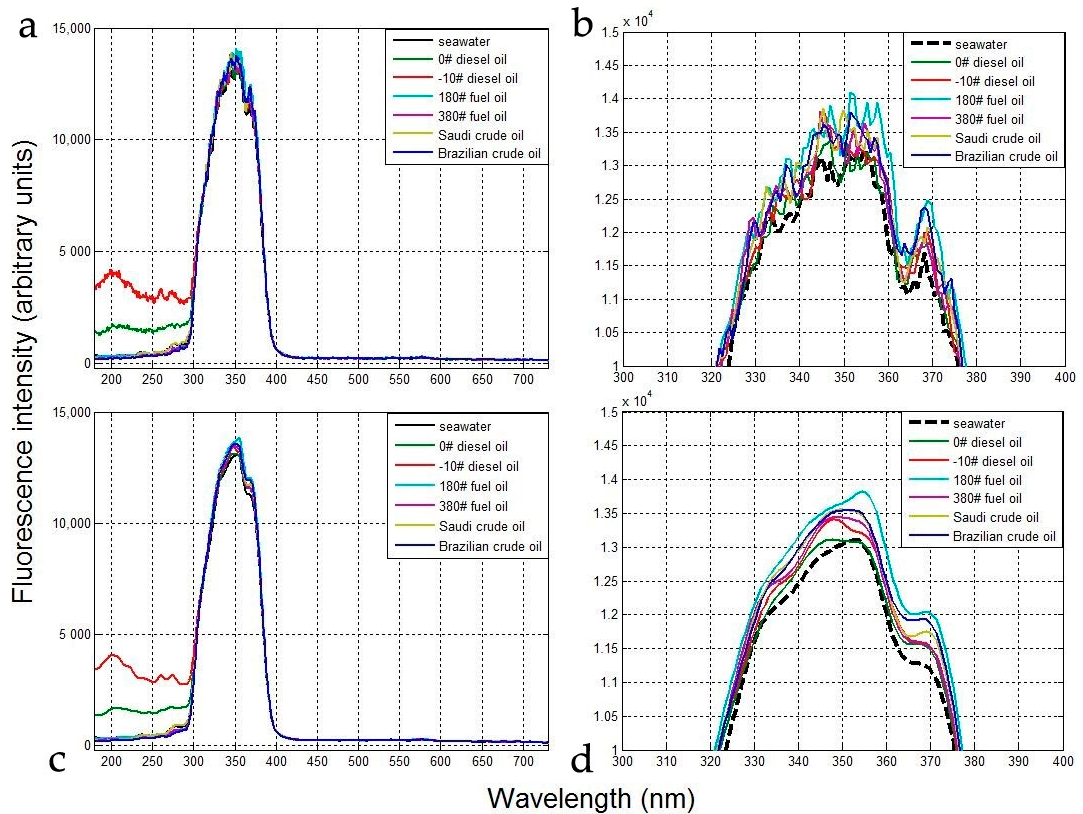
Figure 5. Fluorescence spectra of clean sea water and six oil samples determined with the laboratory- mounted sensor: ( a ) full data; ( b ) magnified area above fluorescence intensity of 10,000 and wavelength of 300–400 nm; ( c , d ) same as ( a , b ), respectively, but after data